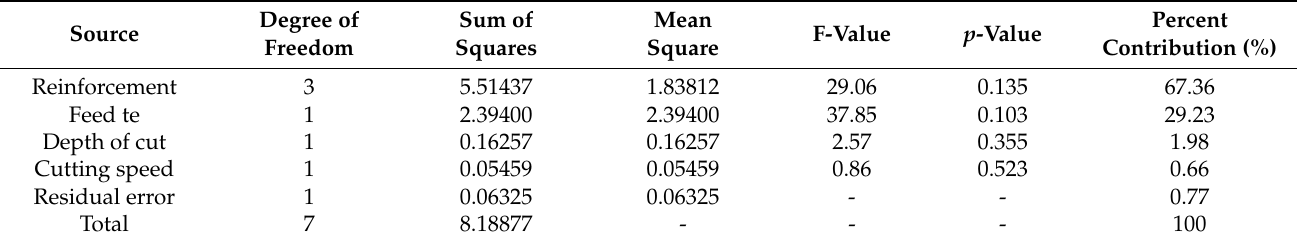
Table 4. Analysis of variance for S/N ratios of surface